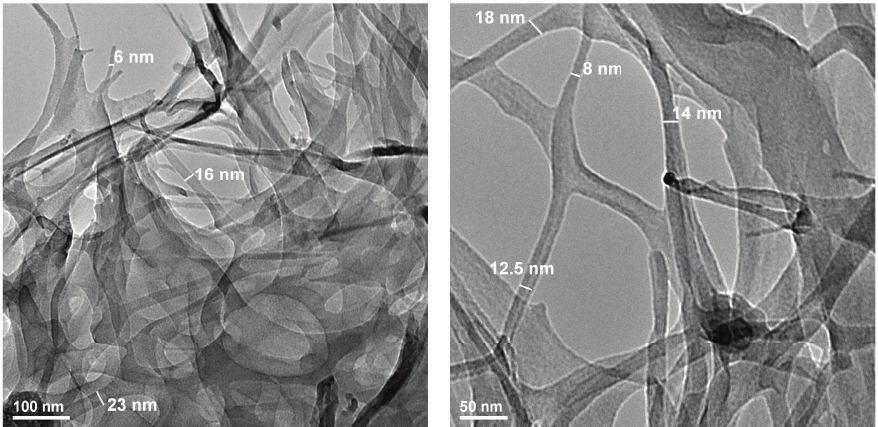
Figure 5: TEM microphotographs of bacterial cellulose.